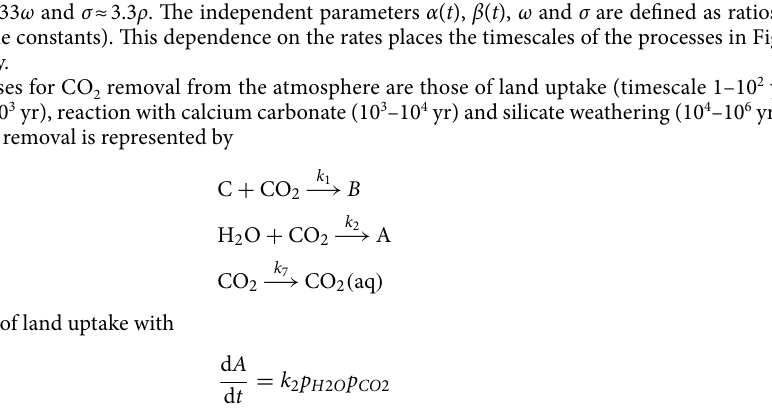
represent from left-to-right Ca-Mg silicate weathering plus sedimentation of marine carbonates. From right- to-left these reactions represent thermal decomposition of carbonates at depth resulting in degassing of CO 2 to the surface 39 .